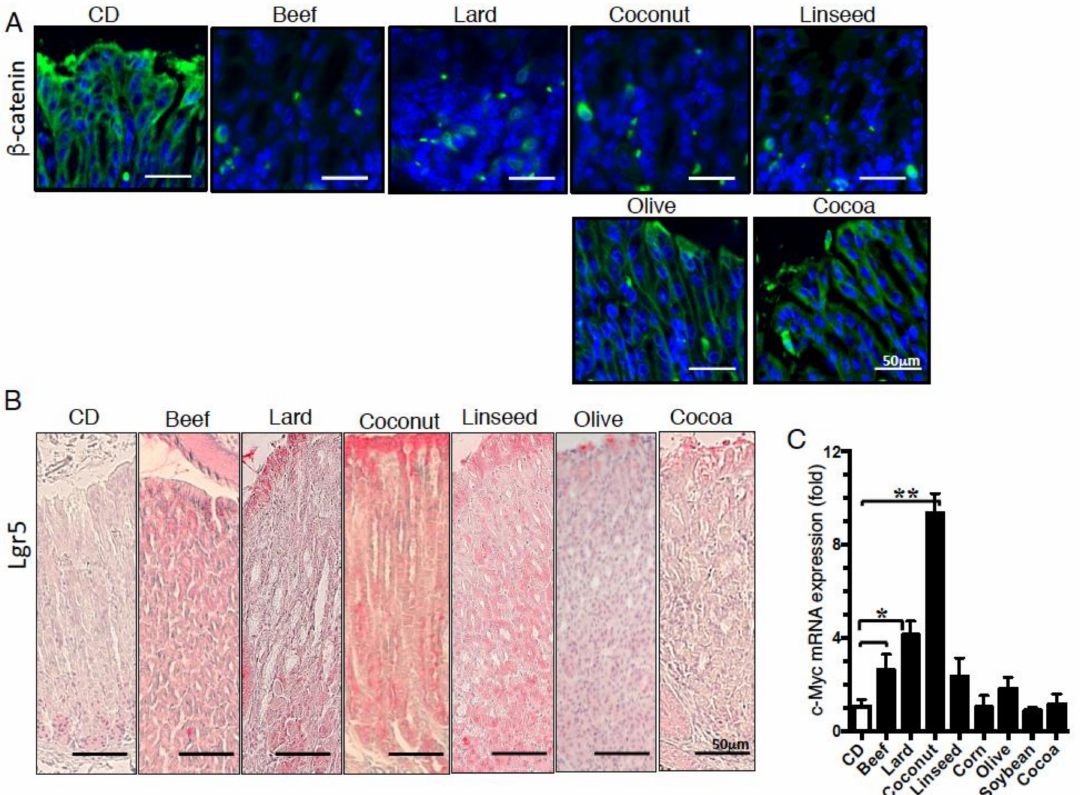
Figure 6. Di ff erence in the intracellular and nuclear localization of β -catenin and the expression of β -catenin target molecules in the gastric mucosa of HFD-fed mice. Staining of the gastric mucosa with ( A ) β -catenin and ( B ) Lgr5 of mice fed experimental diets for 12 weeks. ( C ) mRNA expression of c-Myc of the gastric mucosa in mice fed experimental diets for 12 weeks. Data, shown as mean ± SD were analyzed by the one-way ANOVA followed by Holm-Sidak post-hoc test for multiple comparisons. * p < 0.05, ** p < 0.001. Eight mice per group were